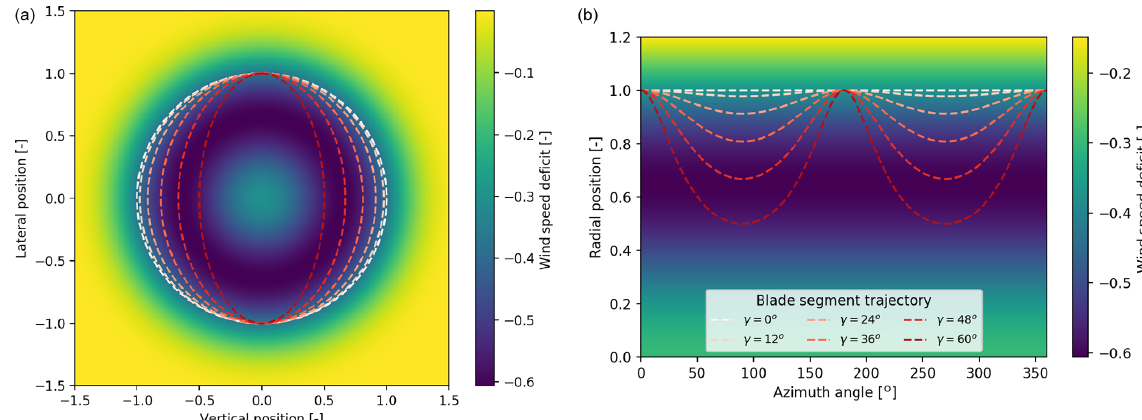
Figure 1. The trajectory of a blade segment close to the blade tip through a wake inflow at varying yaw angles, represented in Cartesian coordinates (a) and unfolded polar coordinates (b) . Distances and wind speeds are normalized by rotor radius, R , and free wind speed,